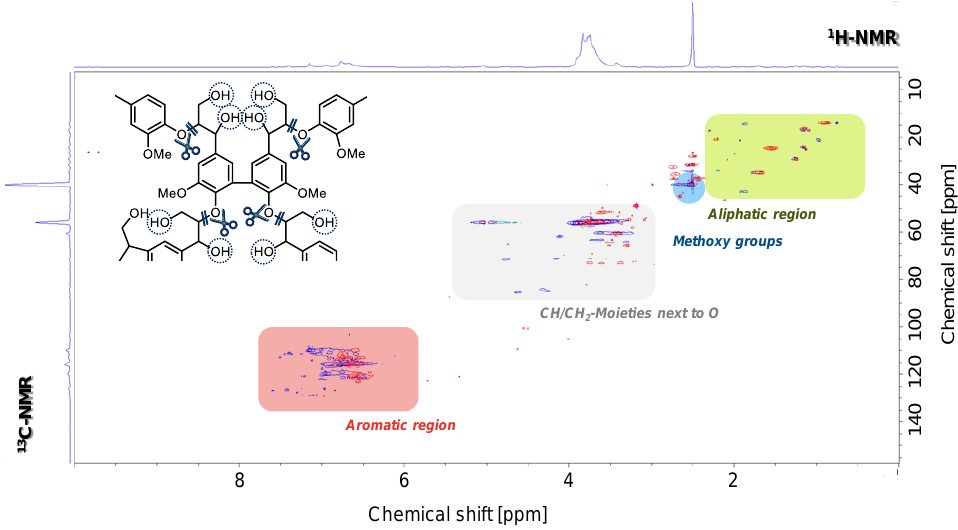
Figure 7. Overlay plot of the HSQC NMR spectra of the parent kraft lignin (blue and green) and the lignin oil (red and pink) obtained by the Ru/C-catalyzed hydrogenolysis of kraft lignin in methanol at supercritical conditions (30 bar initial hydrogen pressure, 131 bar pressure at 250 °C). The insert exemplifies the cleavage of aromatic ether moieties by hydrogenolysis. Bonds that are proposed to be hydrogenolytically cleaved are highlighted with a scissor and the symbol // .